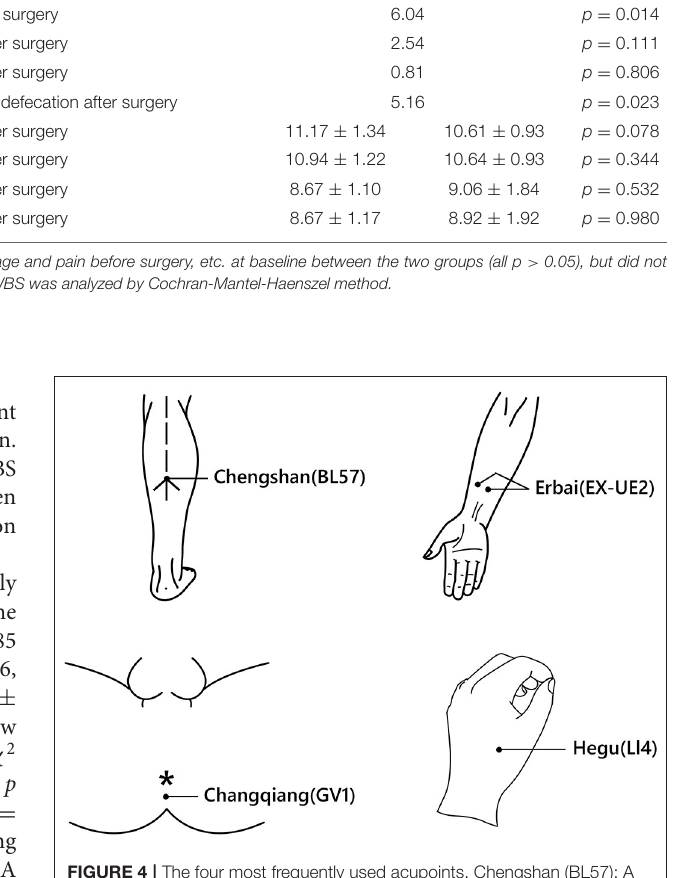
4.63 ± 1.07, p < 0.001) and 7th (2.01 ± 0.96 vs. 4.08 ±